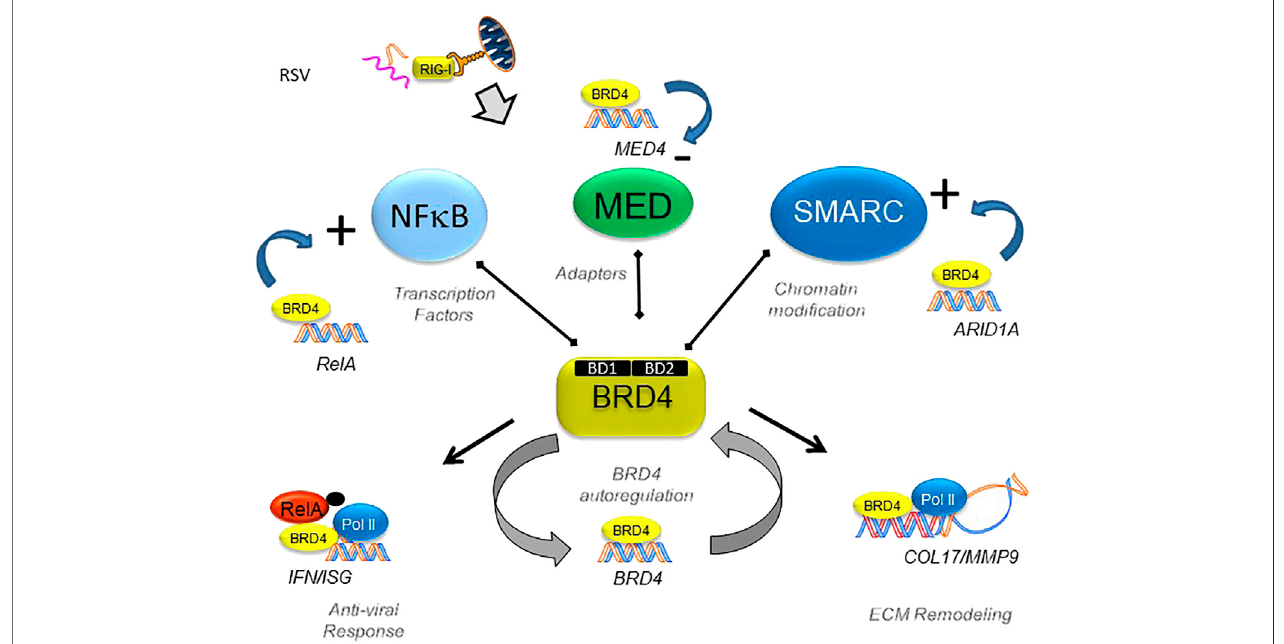
FIGURE11| BRD4 ’ sdynamicallyregulatedgene networks. Schematic diagram ofBRD4-dependentgenesinRSV infection. Although BRD4isrequired for innate signaling and expression of ECM remodeling proteins, this study provides evidence that BRD4 controls its own expression via an autoregulatory network. In addition, BRD4 controls the expression of members of its interacting coactivators that bind the BD, including transcription factors, adaptors, and chromatin remodeling